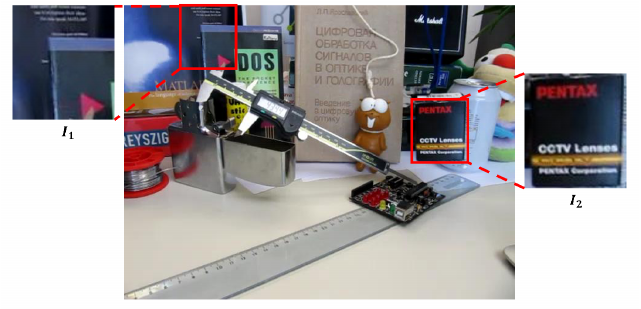
Figure 1. Two images I 1 and I 2 as example of same size.